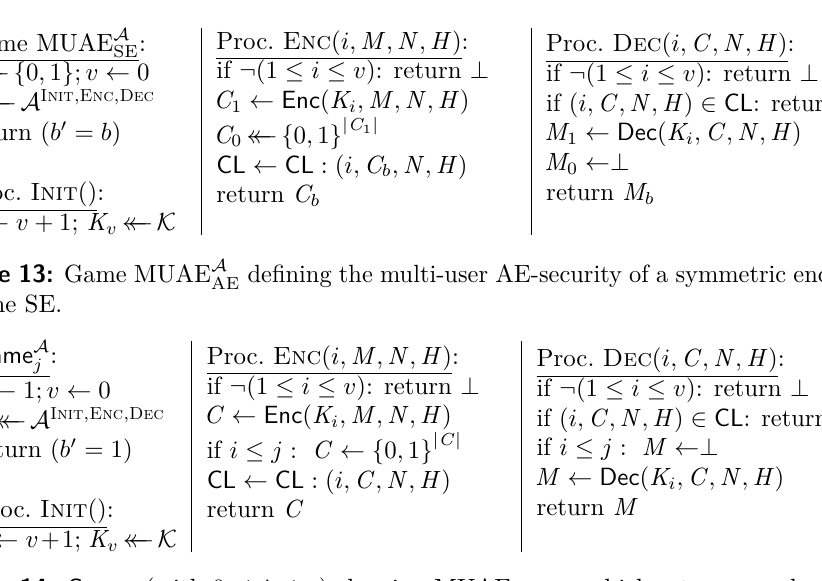
Figure 14: Game j (with 0 ≤ j ≤ n ) showing MUAE game which returns random values when i ≤ j and an encryption under K i